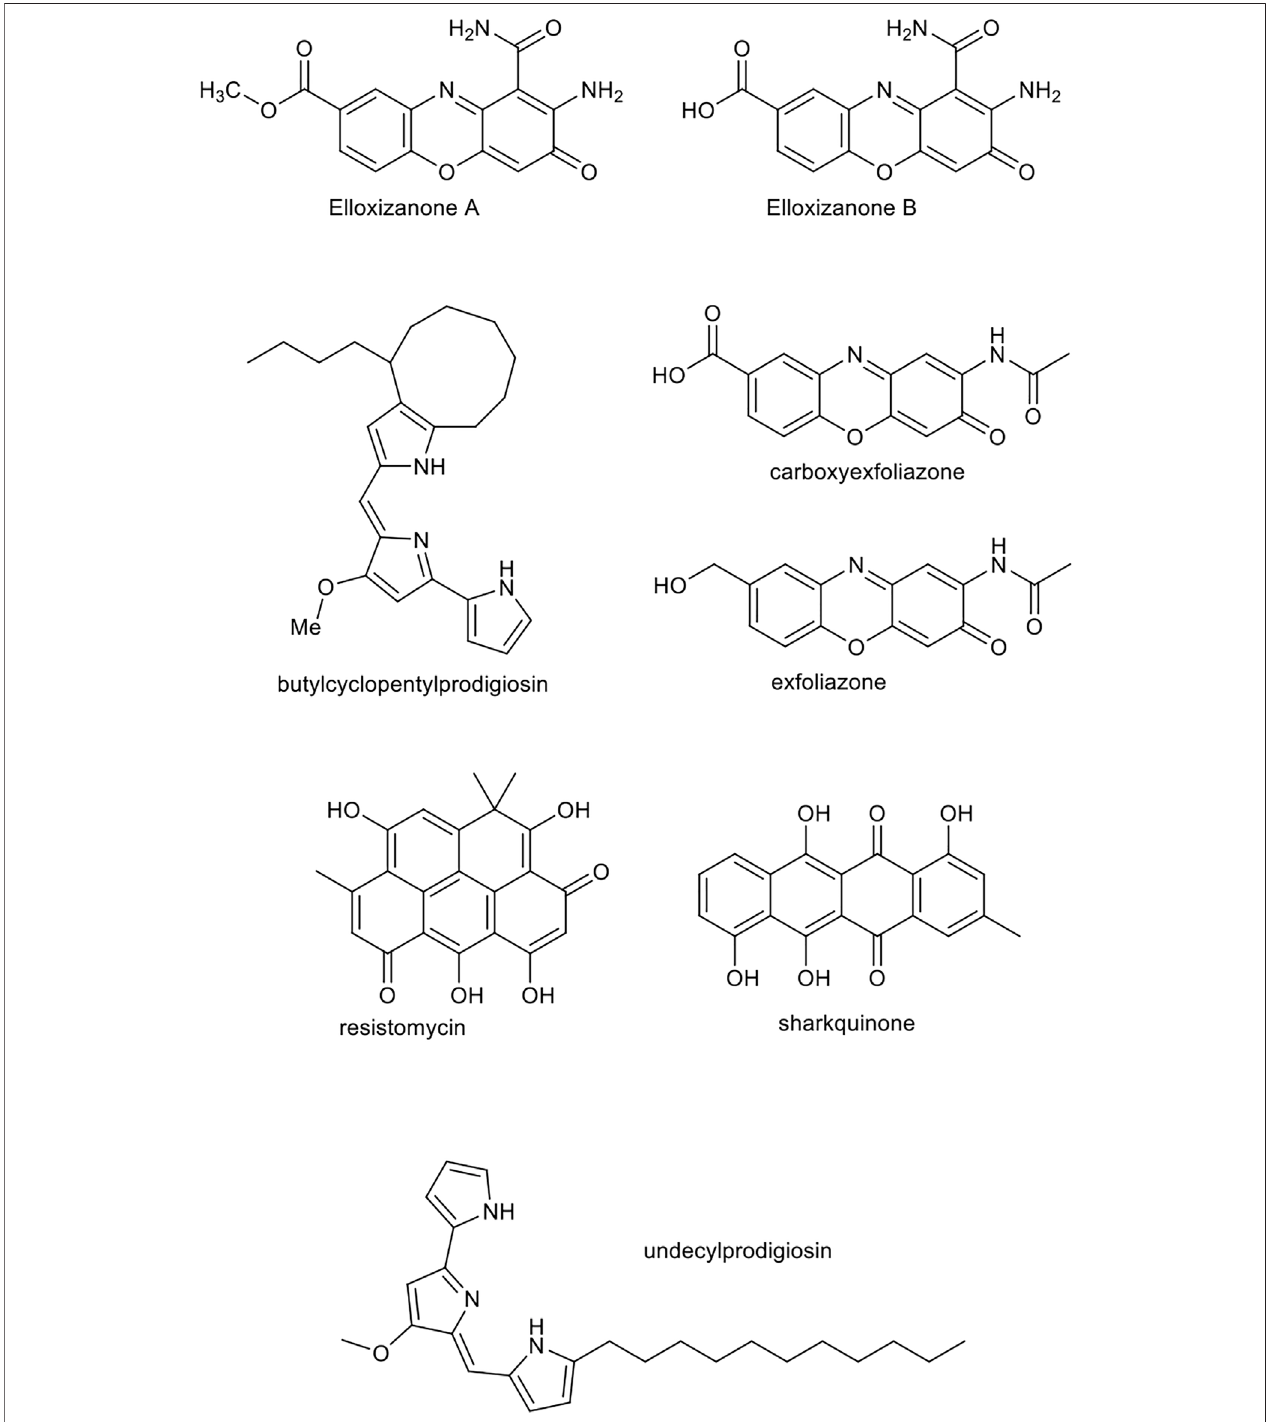
FIGURE 9 | Chemical structure of sharkquinone, resistomycin, undecylprodigiosin, butylcyclopentylprodigiosin, elloxizanones A and B, carboxyexfoliazone and exfoliazone.